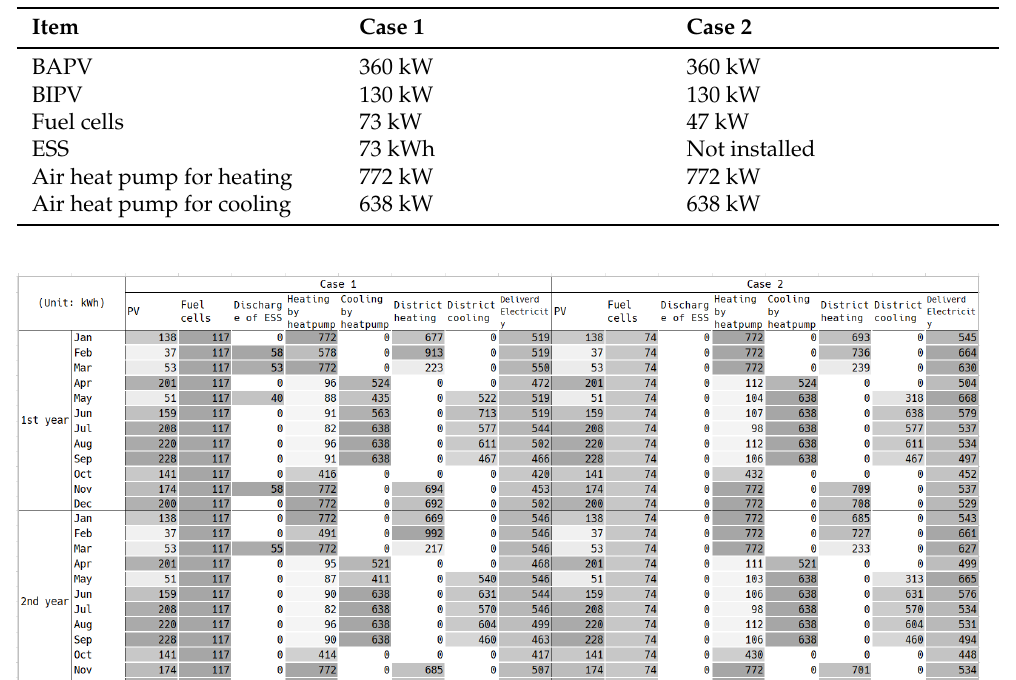
Table 10. Equipment capacity results for each case.